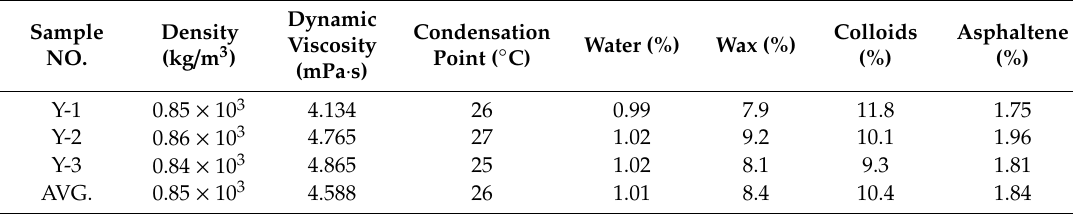
Table 1. Basic physical parameters of crude oil.